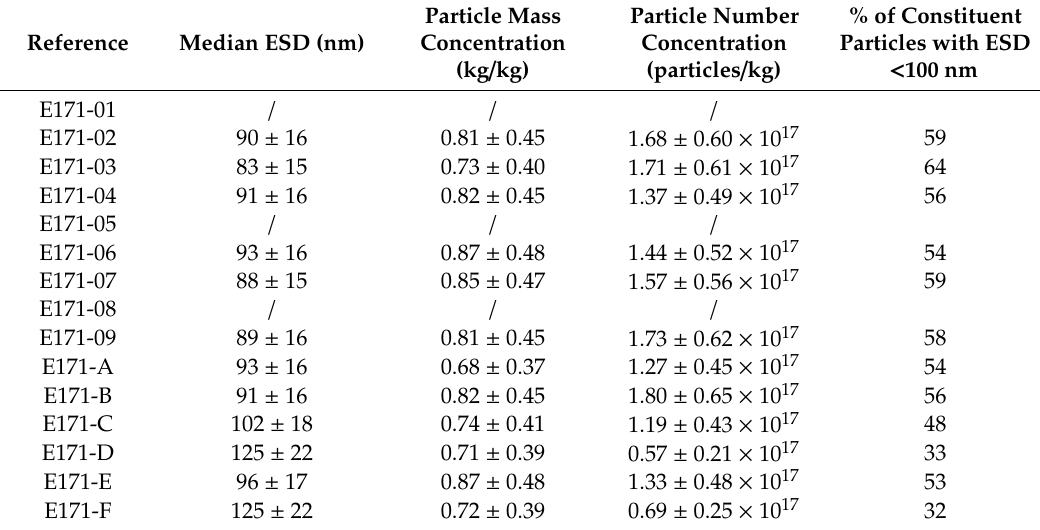
Table 7. Analysis results of the 15 E171 materials, obtained by spICP-MS, including median values of the ESD distributions, particle mass concentration, and particle number concentrations and their respective expanded measurement uncertainties (Ucx, k = 2; Table 4). The % of constituent particles with ESD < 100 nm is